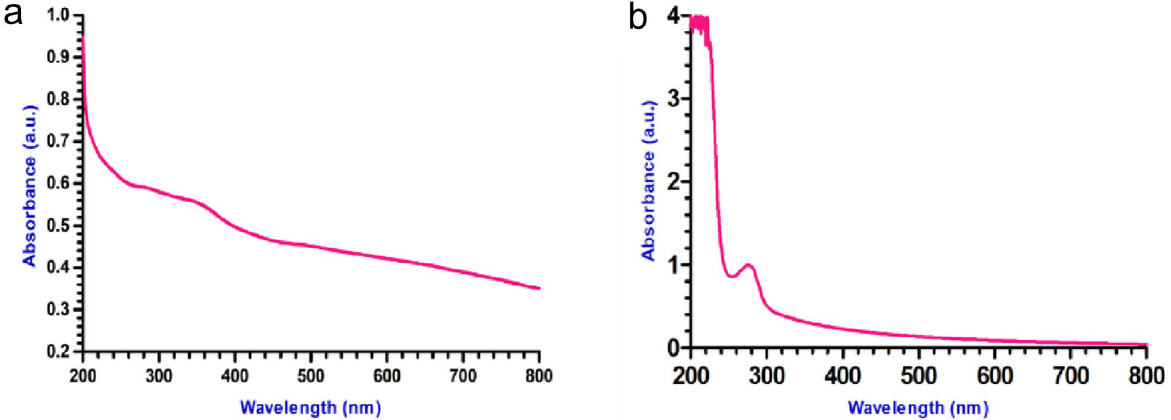
Figure 1. UV–Vis analysis of ( a ) SPIONs; ( b ) Latex coated SPIONs.